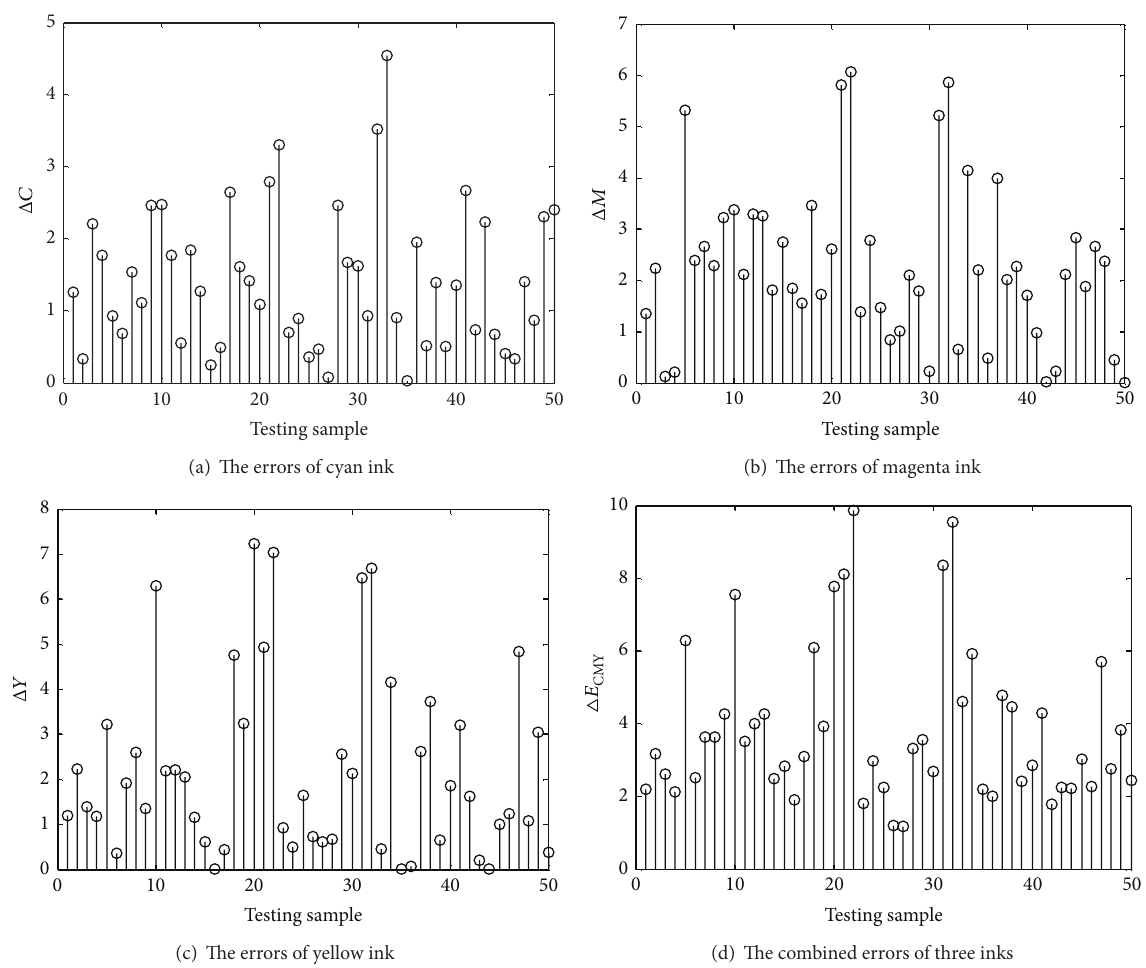
Figure 4: Colorant errors of cyan, magenta, and yellow inks.